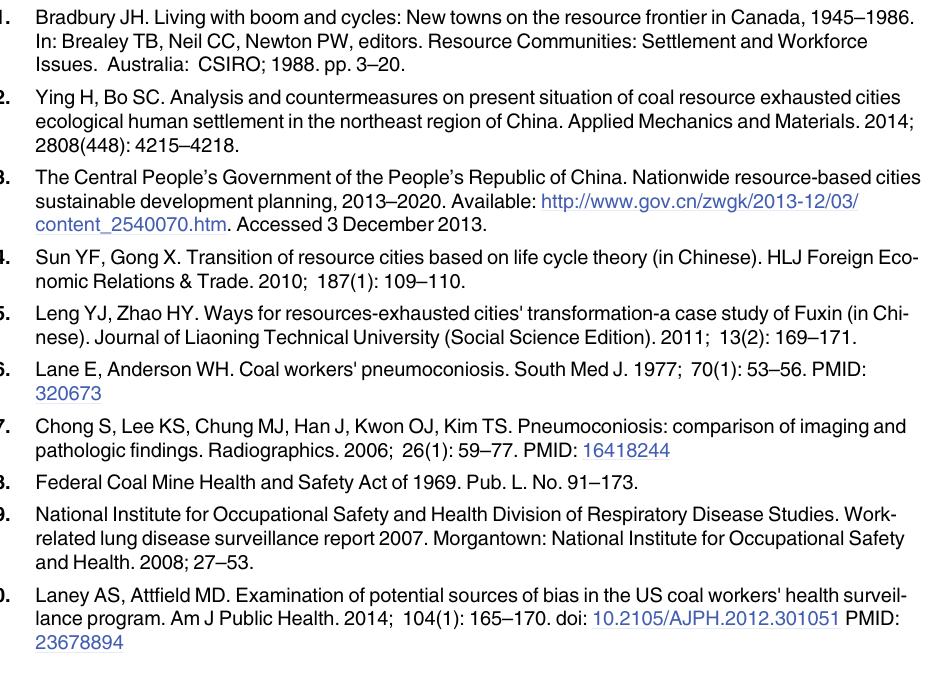
S1 Table. Cumulative incidence rate of CWP in the 1965- tunneling subcohort. S2 Table. Cumulative incidents and average annual incidence of coal workers by year of first dust exposure and occupational category. S3 Table. Age distribution of redeployed coal workers by year of first dust exposure and occupational